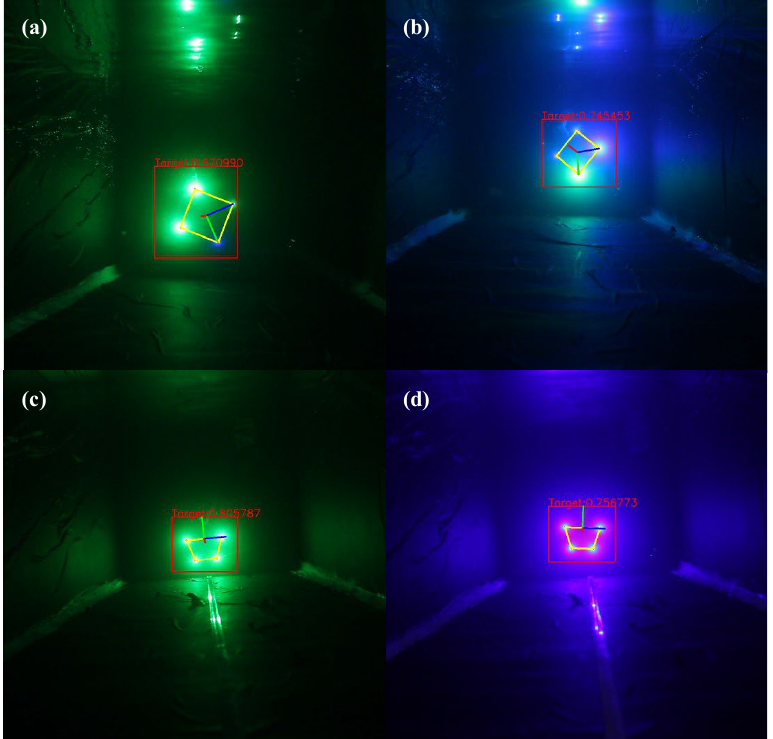
Figure 21. Underwater optical beacon attitude calculation effect diagram: ( a ) Optical beacon of the green cross; ( b ) Optical beacon of the blue cross; ( c ) Optical beacon of the green trapezoid; ( d ) Optical beacon of the blue trapezoid.